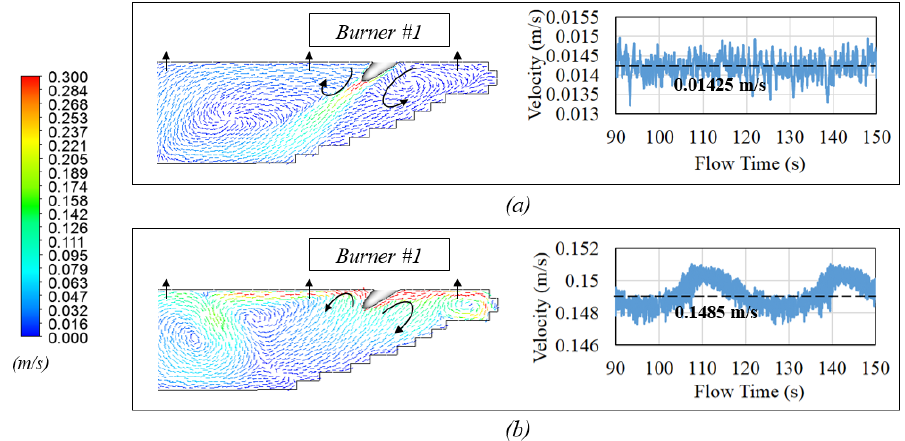
Figure 8. ( a ) Momentum stirring without bubble stirring; ( b ) Momentum stirring together with bubble stirring. bubble